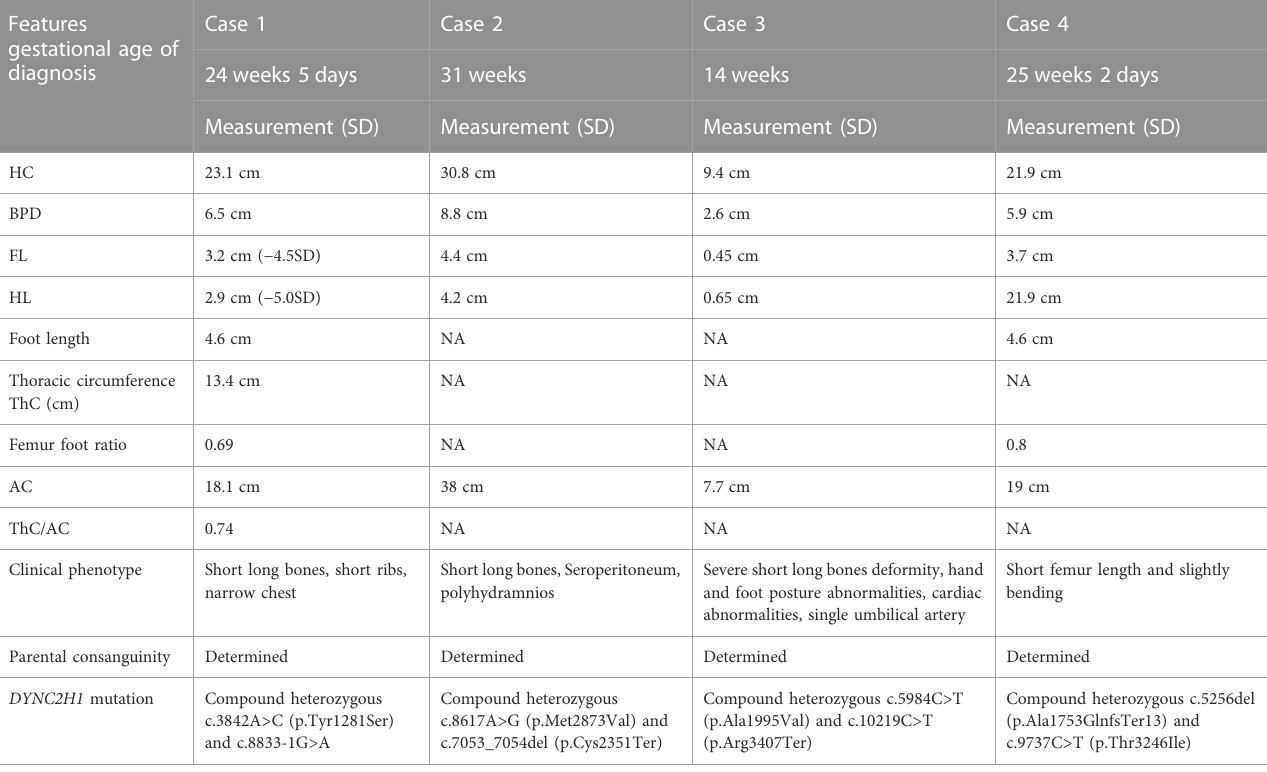
TABLE 1 Clinical details: antenatal ultrasound and molecular studies of cases. Features gestational age